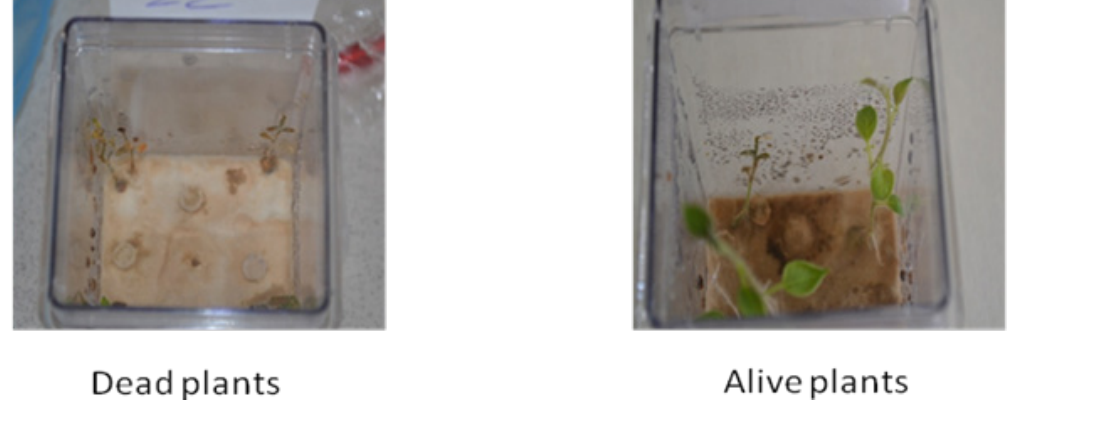
Figure 1: Irradiation treatments of potato cultivar (Alanso) after infection with R. solani.